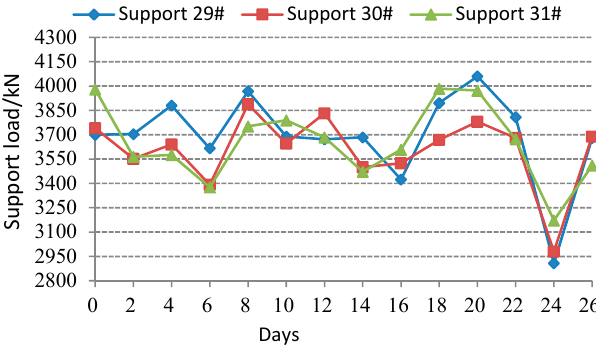
Figure 9. Behavior of the support load in the middle area of the working face.